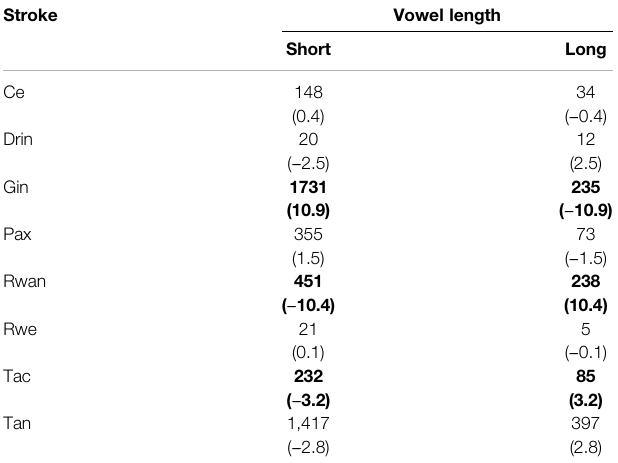
Absolute adjusted standardised residuals greater than three are highlighted in bold.